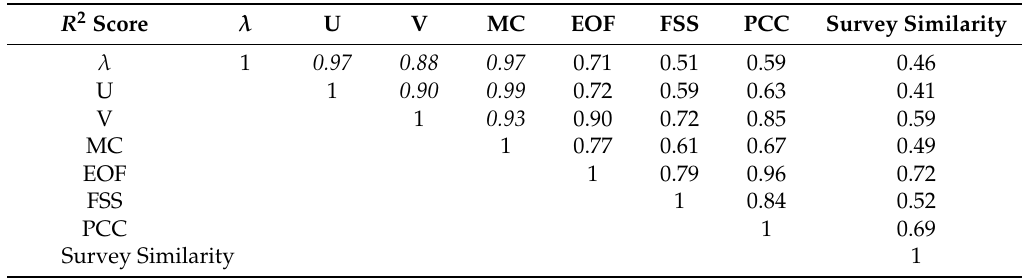
Table 5. Coefficient of determination ( R 2 ) between spatial metrics and survey similarity. Bold values mark metrics with highest ability to reproduce survey similarity. Italic values highlight spatial metrics which are highly